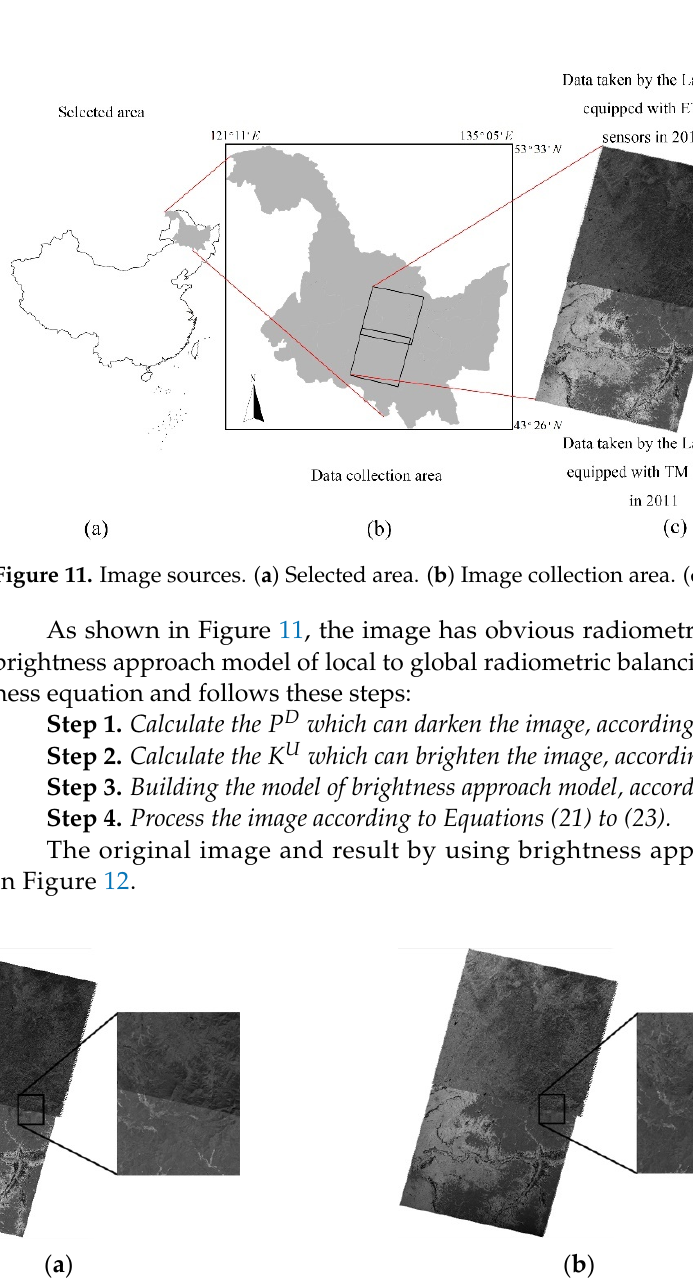
Figure 10. The result of local brightness balancing. ( a ) The image before process. ( b ) The image after process.